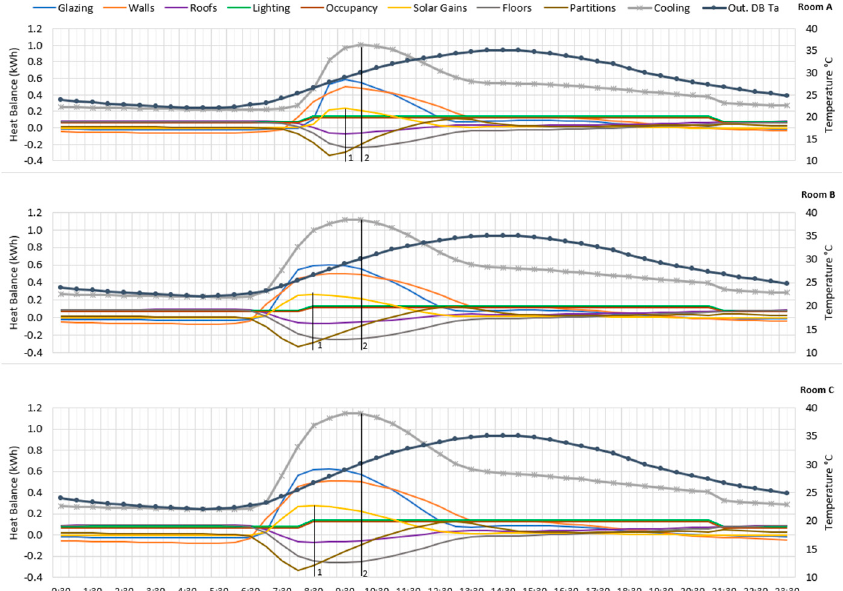
Figure 9. Internal heat balance of the rooms and outside dry-bulb temperature on July 15th. Peak load from solar gains 1 and peak load from cooling demand 2 in rooms analysed.